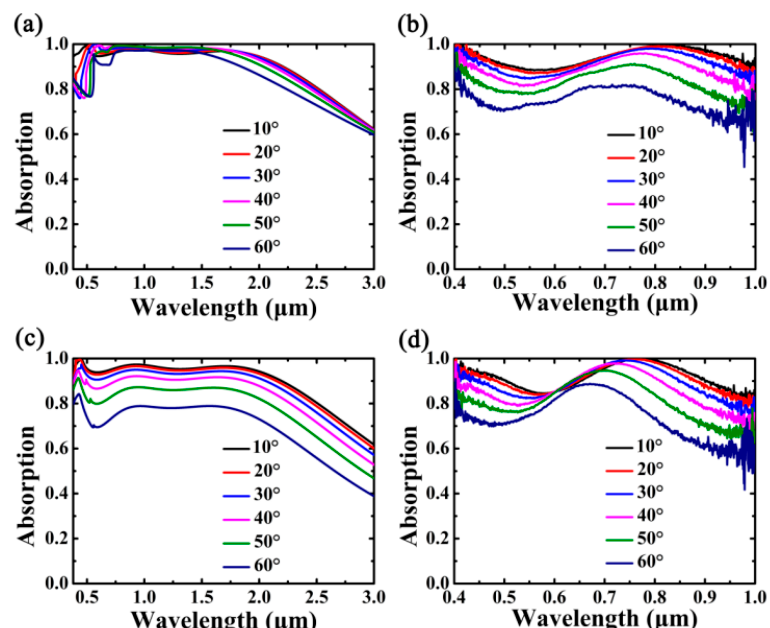
Figure 5. Absorption curves of the Cr-based MA at oblique incidence. Other parameters are kept the same as Figure 1a. ( a , b ) are the simulated and measured absorption of TM polarization, respectively. ( c , d ) are the simulated and measured absorption of TE polarization, respectively.